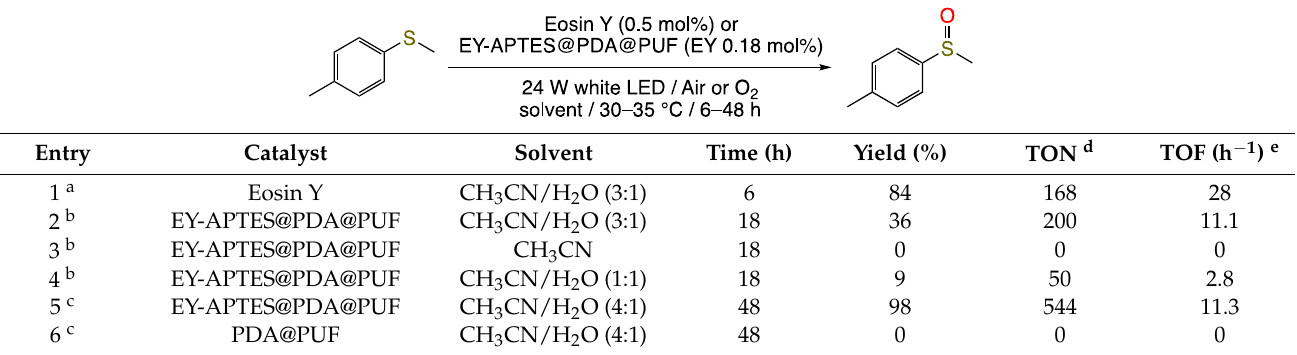
Table 2. Optimization of the reaction conditions for the oxidation of methyl p -tolyl sulfide under